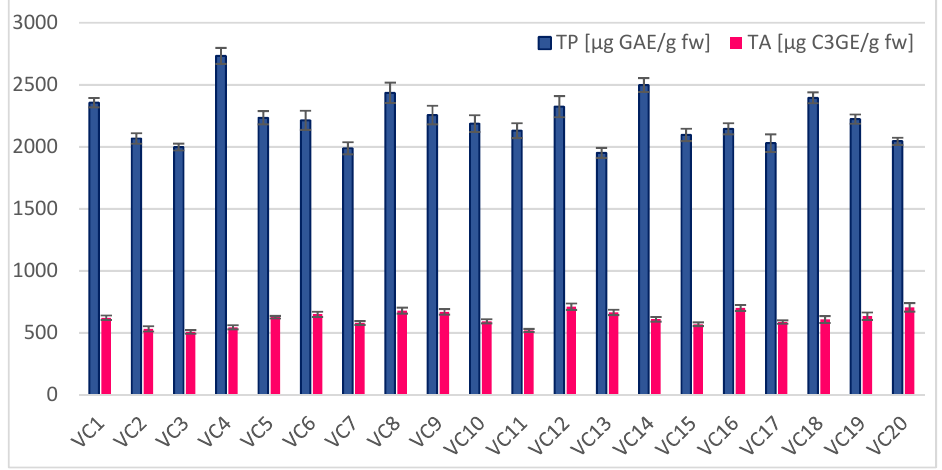
Figure 1. Content of total phenolics (TP) and total anthocyanins (TA) in fruits of 20 black mulberry ( M. nigra ) genotypes (VC1–VC20).